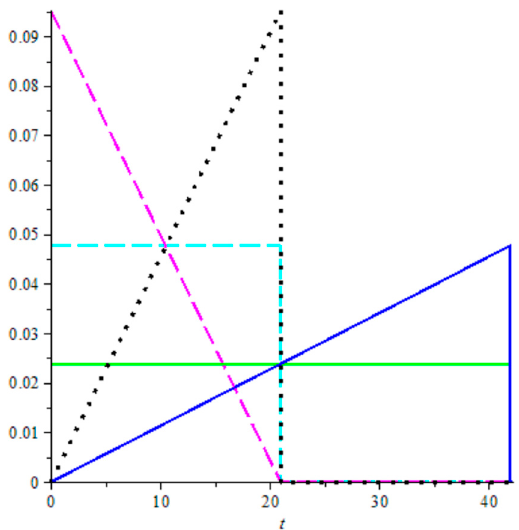
Figure 7. Graphs of the probability density functions of travel times for trips and cycles in a one-dimensional zone with T = 42 s: Cyan dashed f ( τ K ) for a semi-random trip from / to the storage / retrieval (S / R) station; magenta dashed f ( τ ) for a random trip between two random locations; black dotted f ( τ MAX ) for the maximal value of two semi-random trips; green solid f ( τ SC ) for a single command (SC) cycle; blue solid f ( τ DC ) for a dual command (DC) cycle.